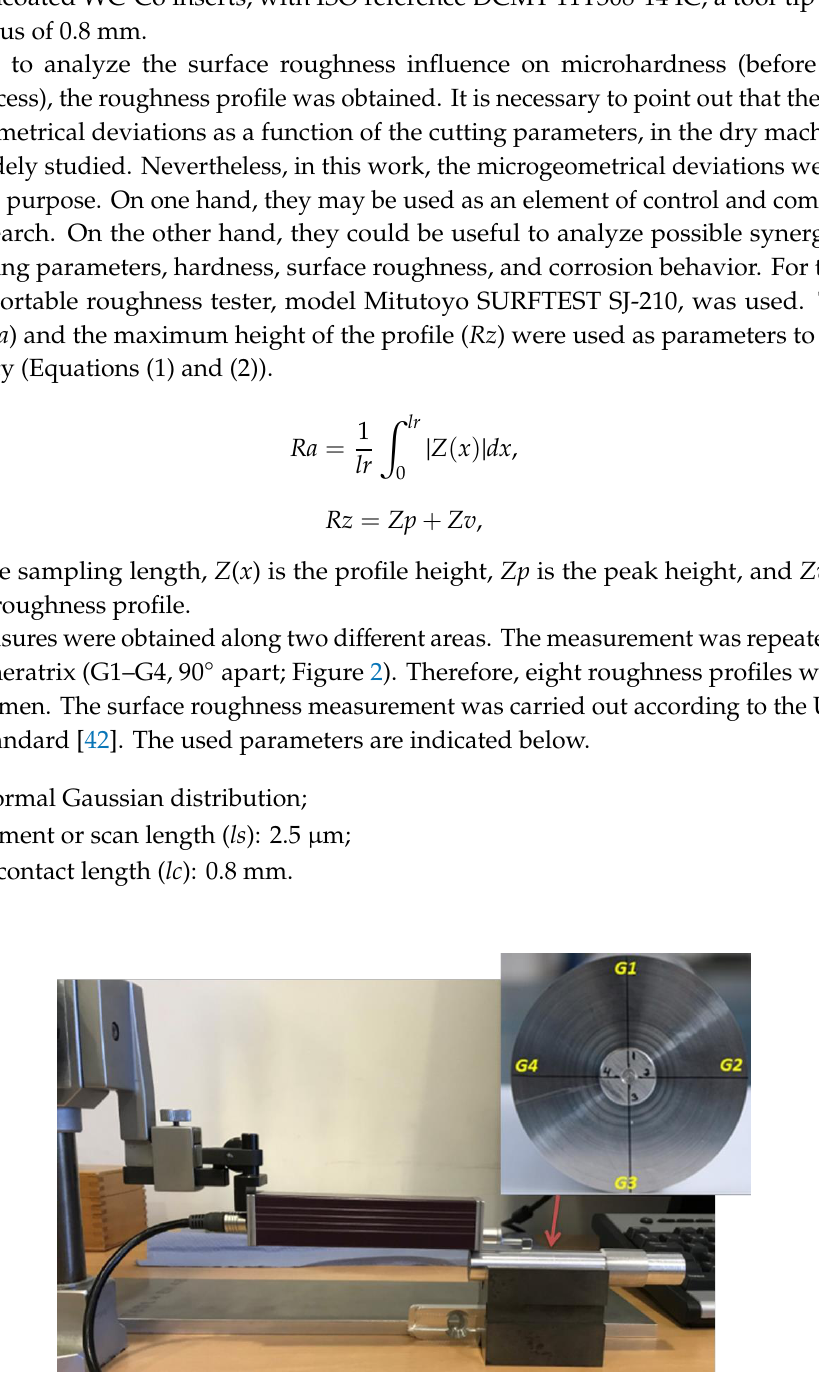
Figure 2. Roughness profile measurement set-up.